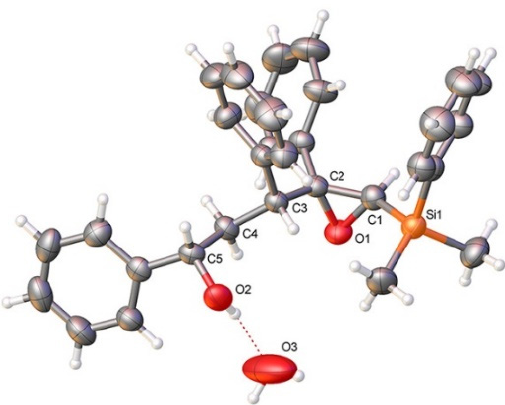
Figure 2. X-ray crystal structure of 4e ; displacement ellipsoids at 50% probability. Colour key: C (grey), N (blue), O (red), Si (orange). CCDC: 2118173.